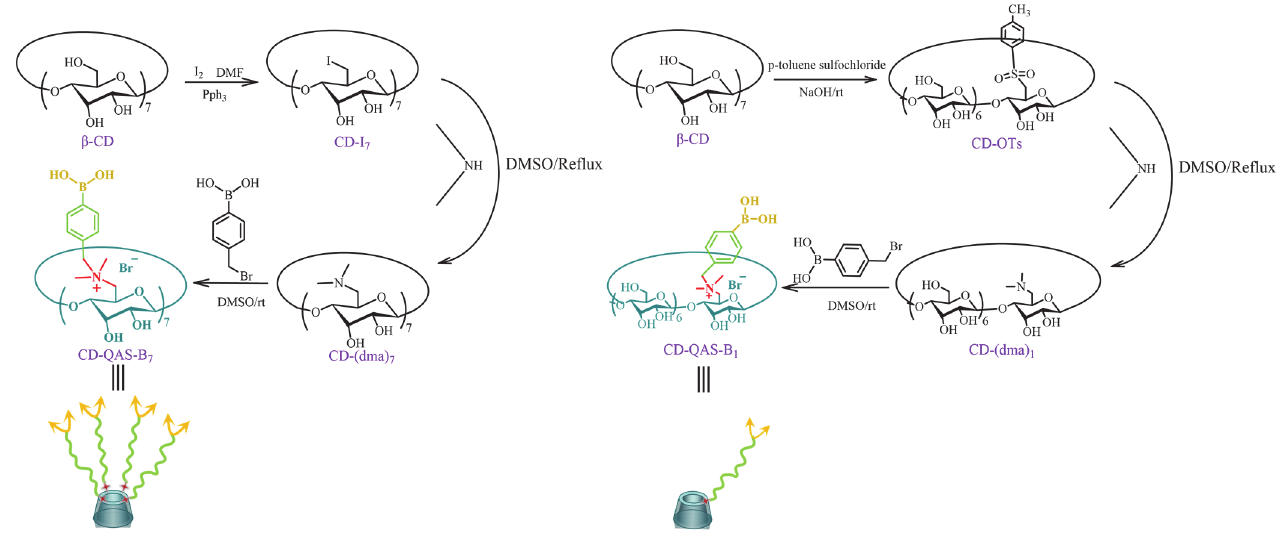
Figure 1. Synthetic route for CD-QAS-B.